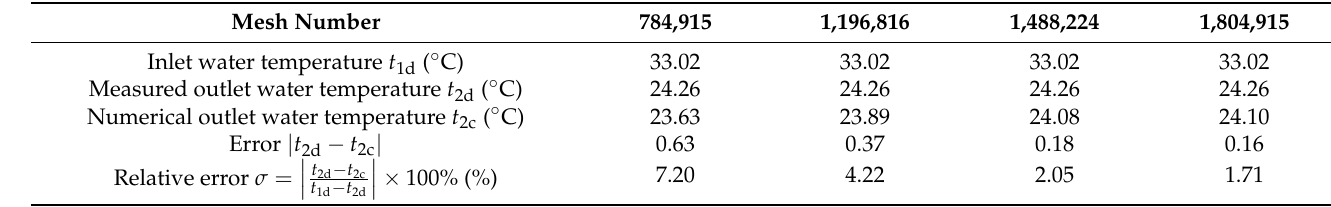
Table 1. Mesh independence